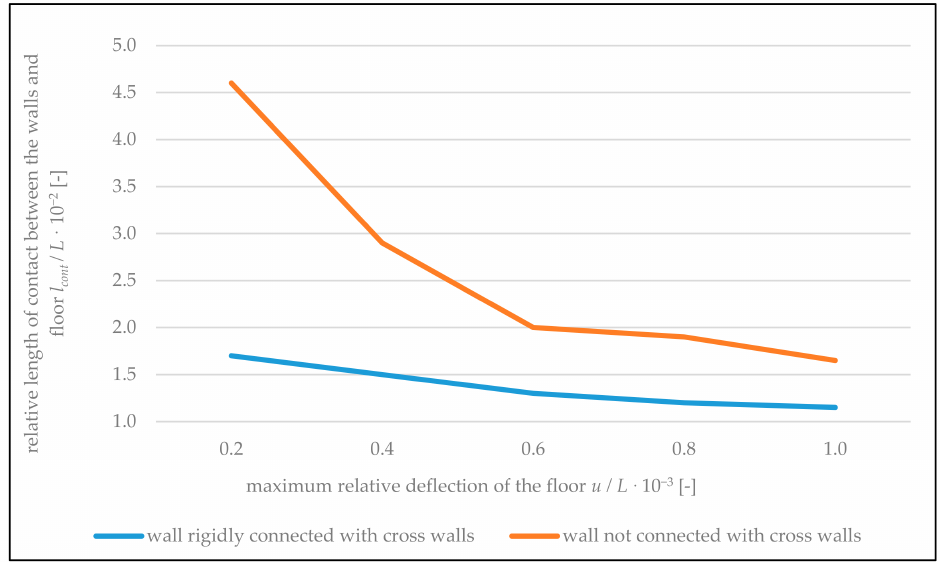
Figure 16. Graphs of the relative length of contact between the walls and floor l cont/ L , depending on maximum relative deflection of the floor u / L .